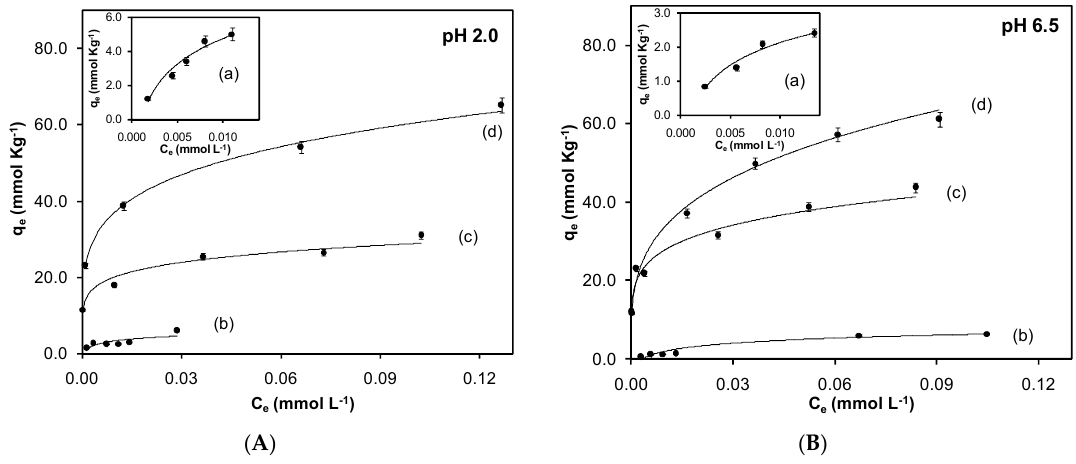
Figure 4. Effect of pH ( A ) 2.0 and ( B ) 6.5 on the adsorption. ( a ) Fe 3 O 4 ; ( b ) Fe 3 O 4 -MAA; ( c ) Fe 3 O 4 -MAA-IL; ( d ) Fe 3 O 4 -IL.